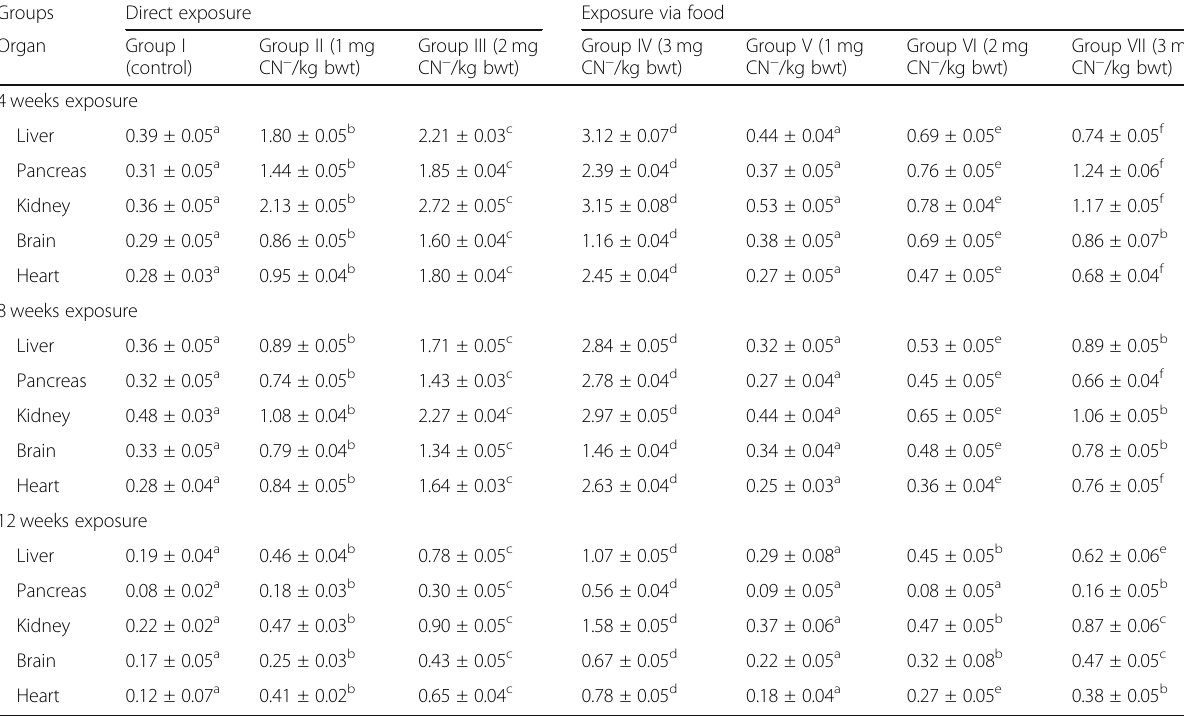
Table 1 The bioaccumulation of cyanide in the organs of birds exposed to cyanide directly and indirectly in feed Groups Direct exposure Exposure via